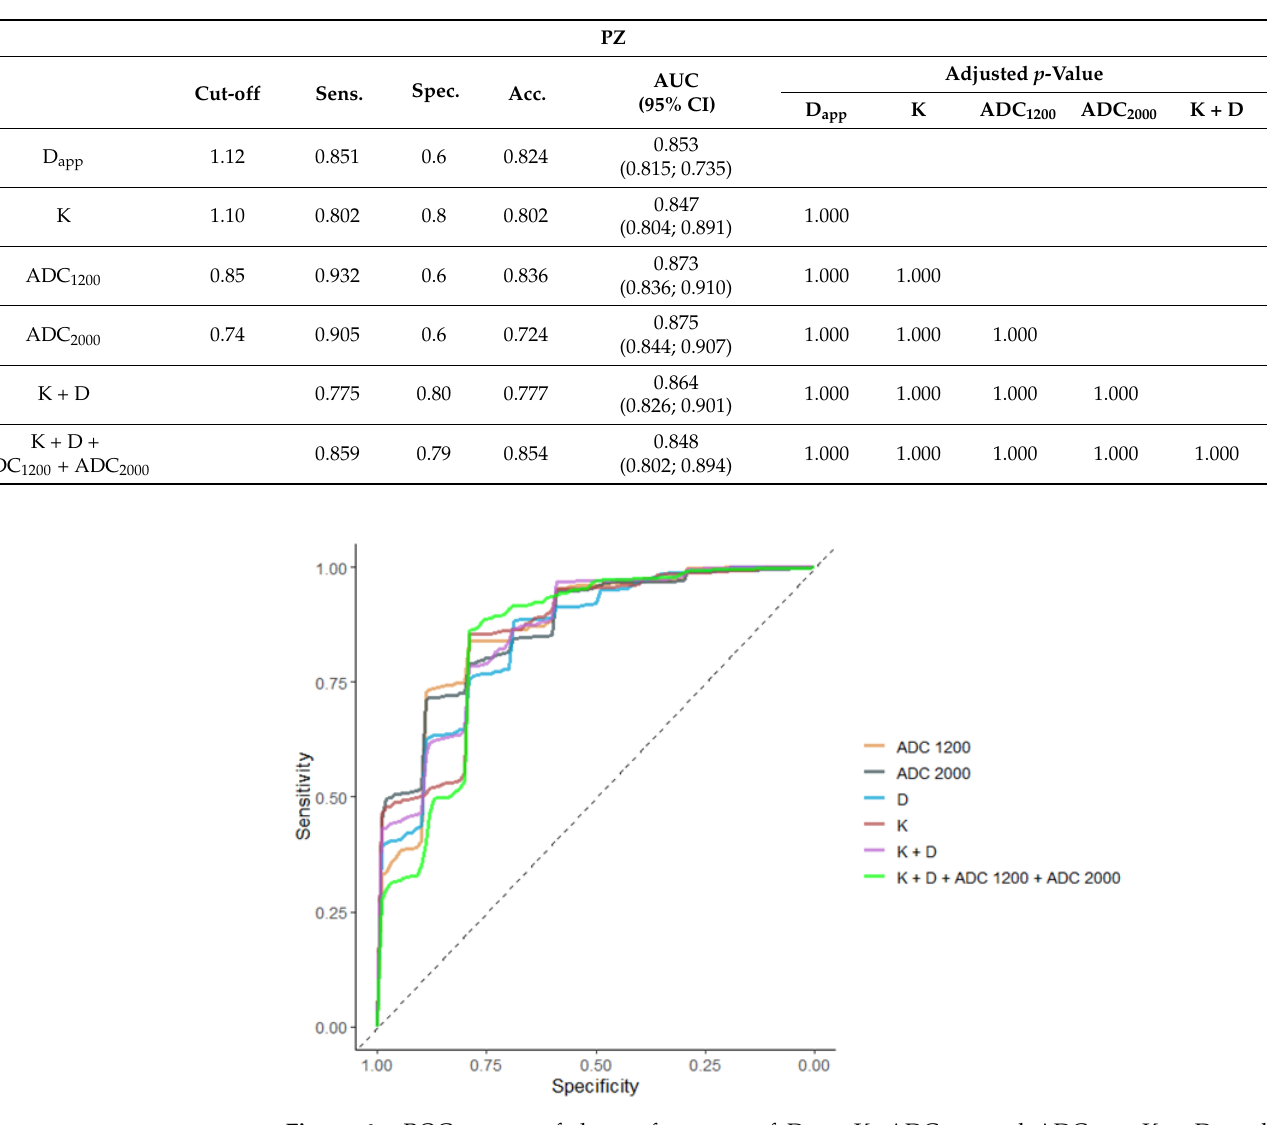
Table 5. Diagnostic performance in differentiating GS ≤ 3 + 3 and GS ≥ 3 + 4 tumors in the peripheral zone of D app , K, ADC 1200 , and ADC 2000 , the combination of D app and K together, the combination of D app + K + ADC 1200 + ADC 2000 together, and cut-off values for D, ADC × 10 −3 mm 2 /s) and K determined by Youden index.